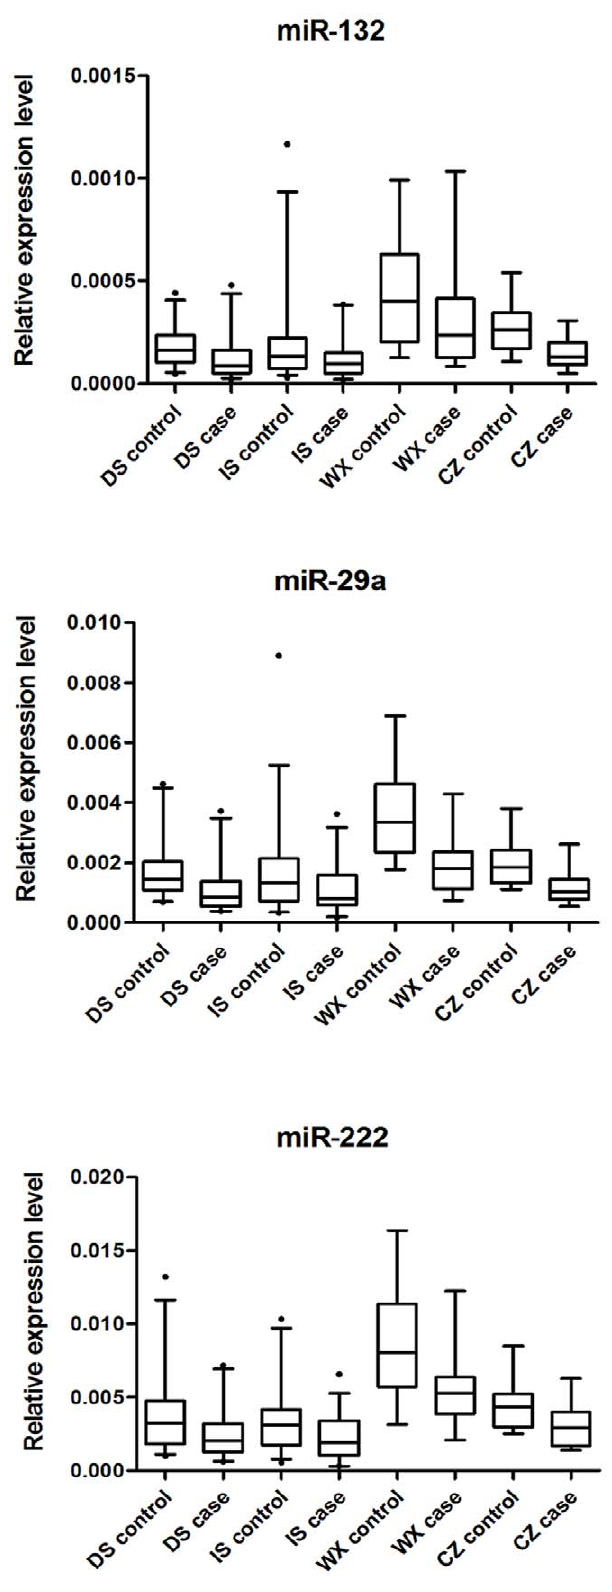
Figure 1. Expression levels of miRNAs. DS: discovery stage; IS: internal validation stage; WX: Wuxi; CZ: Changzhou Three serum miRNAs were quantified by qRT-PCR in patients with subsequent GDM and matched controls (n=24, 36, 16 and 16 each for DS, IS, WX and CZ,